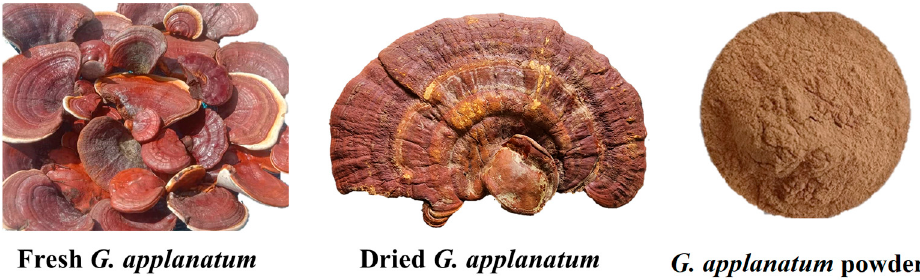
Figure 1. The appearance of G. applanatum in different